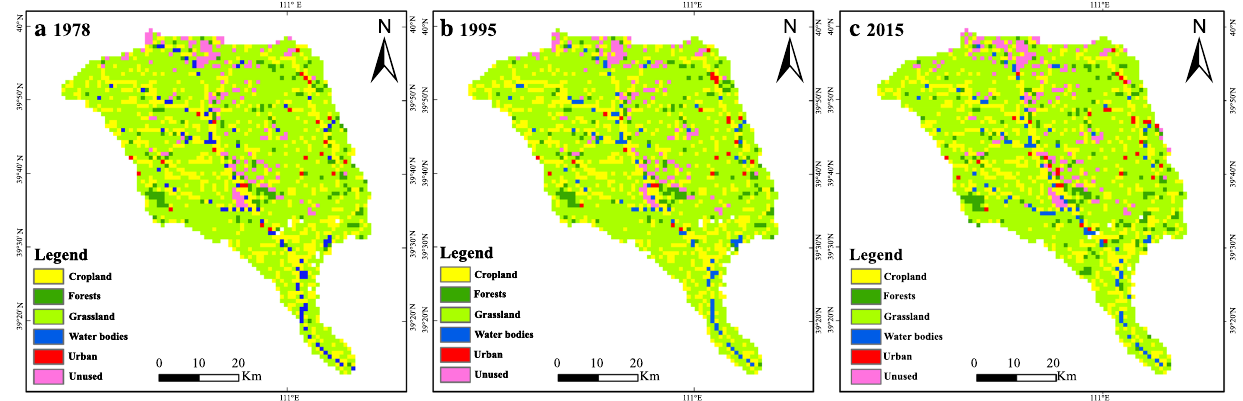
Fig. 6 Land use types of Huangfuchuan River basin in typical